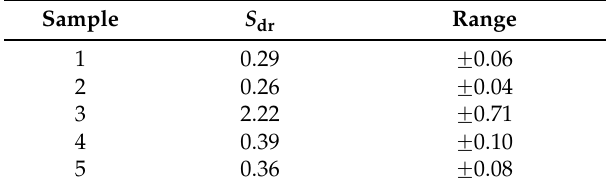
Table 3. Surface roughness values of APEX samples from Table 1.